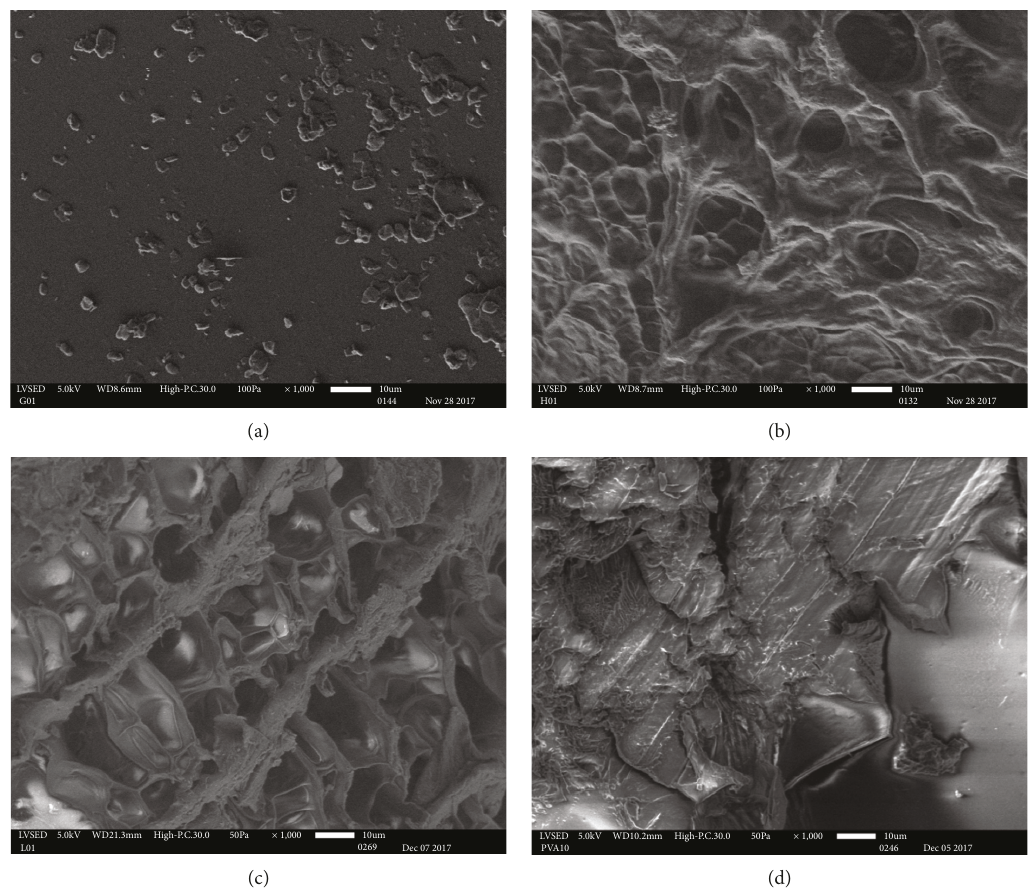
Figure 11: Scanning electron micrographs of hydrogels at 1K resolution. The samples used for this analysis were (a) 0.20 solely gelatin (20% gelatin), (b) H.6.20 (6% HOP and 20% of gelatin), (c) L.6.20 (6% LOP and 20% of gelatin), and (d) N.6.20 (6% NOP and 20% of